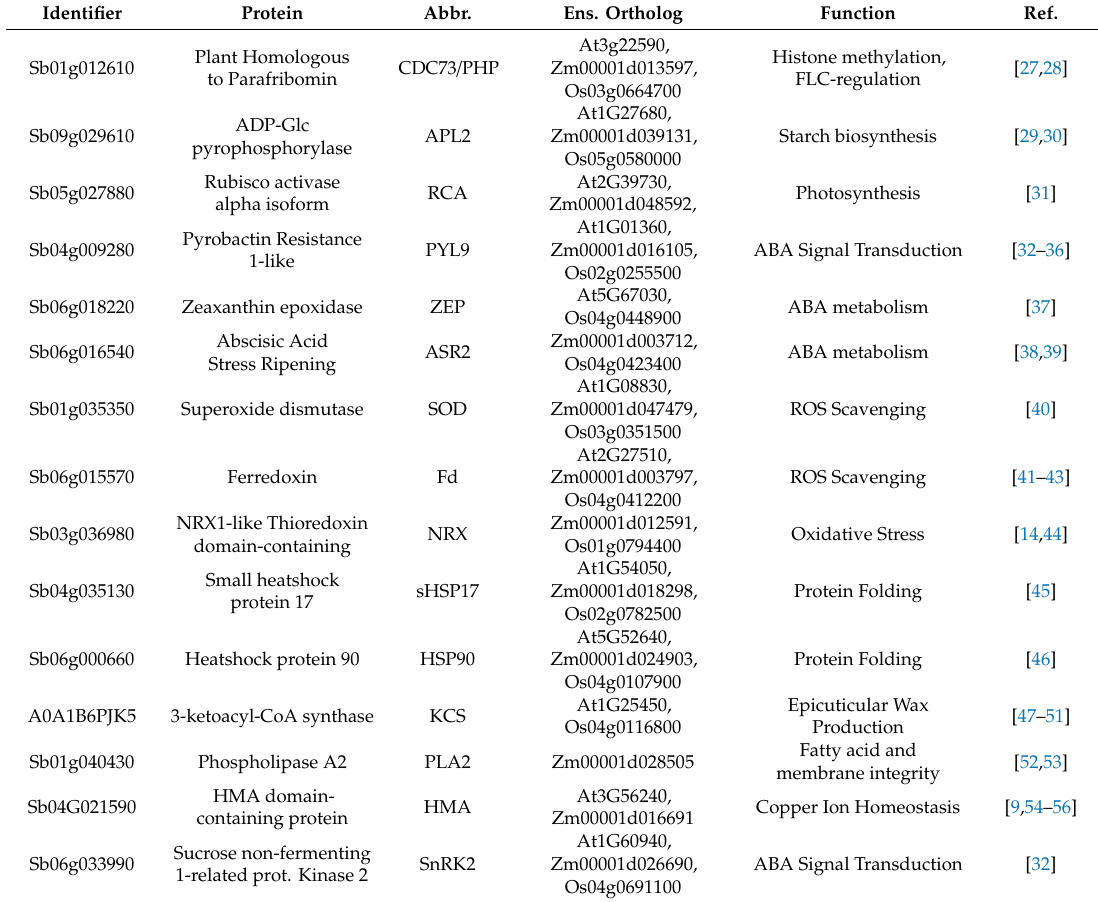
Table 1. RTx430-specific drought responsive